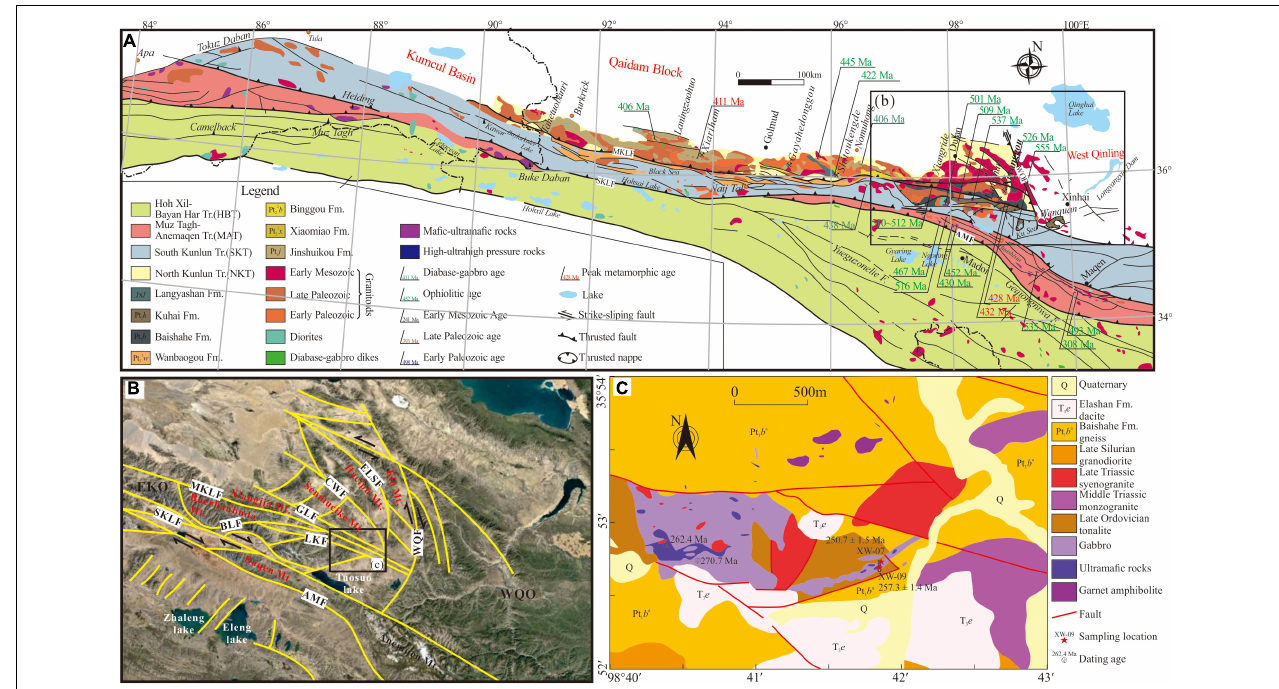
FIGURE 1 | (A) Sketch map showing the distribution of mafic–ultramafic complex and Cu–Ni sulfide mineralization in the East Kunlun Mountains, the northern part of the Qinghai-Tibet Plateau (modified after Dong et al., 2018); LA-ICP MS zircon U–Pb ages from other studies are also shown in Dong et al. (2018) and Yu et al. (2020). (B) Satellite map of the Xiwanggou area showing the fault syst. WQF, Wenquan fault; ELSF, Elashan fault; CWF, Chahanwusu fault; GLF, Gouli fault; MKLF, Middle Kunlun fault; BLF, Boluoer fault; LKF, Longwakalu fault; SKLF, South Kunlun fault; AMF, Anemaqen Fault. (C) Simplified geological map of the Xiwanggou area showing sample and trench localities. Modified after Kong et al.